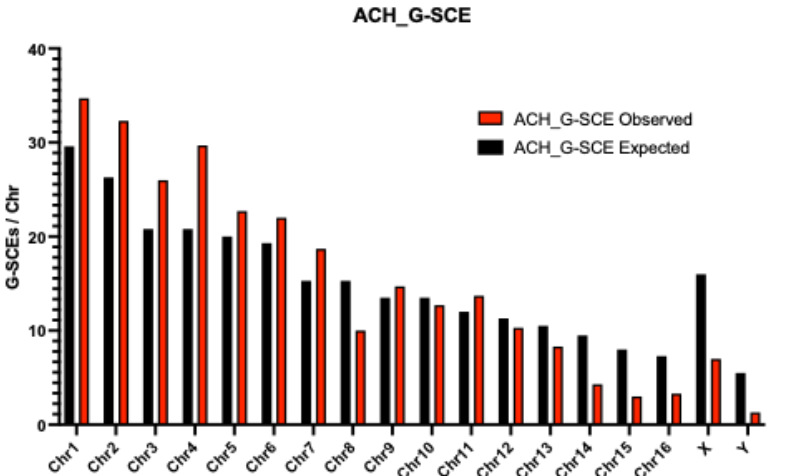
CO-FISH detection of telomeres on Ateles metaphases confirmed the expected num- ber of telomeric signals in both A. paniscus (64) and A. chamek (68) (Figure 6). However, Figure 5. Number of observed (red) and expected (black) G-SCEs for each chromosome pair of A. Figure 5. Number of observed (red) and expected (black) G-SCEs for each chromosome pair of marked differences between the species in the frequencies of telomeric recombination/ex- chamek . A. chamek . change events (T-SCEs) were observed.